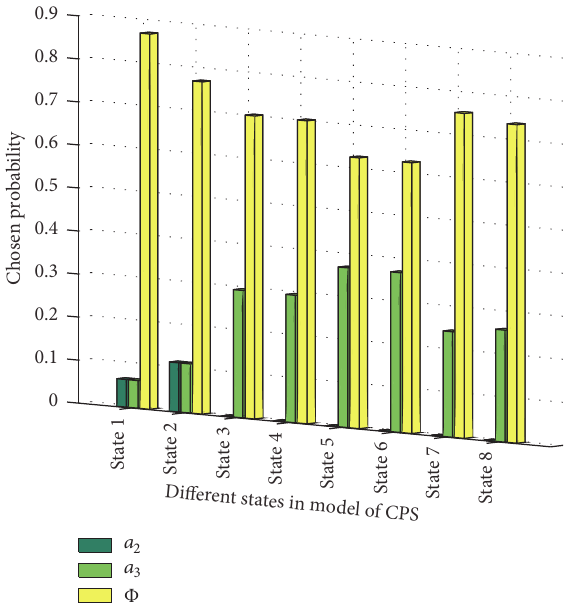
Figure 8: Optimal strategies for rational attacker.